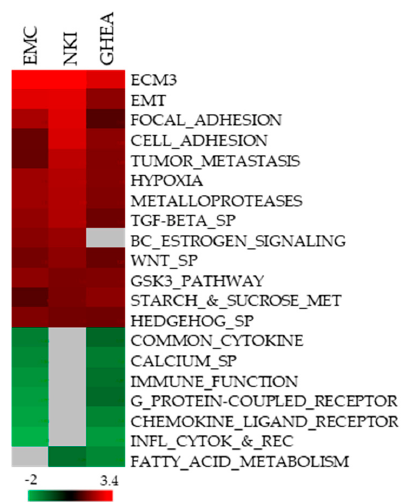
Figure 1. Molecular characteristics of HER2-positive breast cancers (BCs) according to ECM Figure1. MolecularcharacteristicsofHER2-positivebreastcancers(BCs)accordingtoECMclassification. classification. Heatmap shows the normalized enrichment scores (NES) of gene sets significantly Heatmapshowsthenormalizedenrichmentscores(NES)ofgenesetssignificantlyenrichedatFDR < 25% enriched at FDR < 25% in ECM3 tumors in at least two datasets, by GSEA analysis. Grey boxes in ECM3 tumors in at least two datasets, by GSEA analysis. Grey boxes indicated no indicated no enrichment.